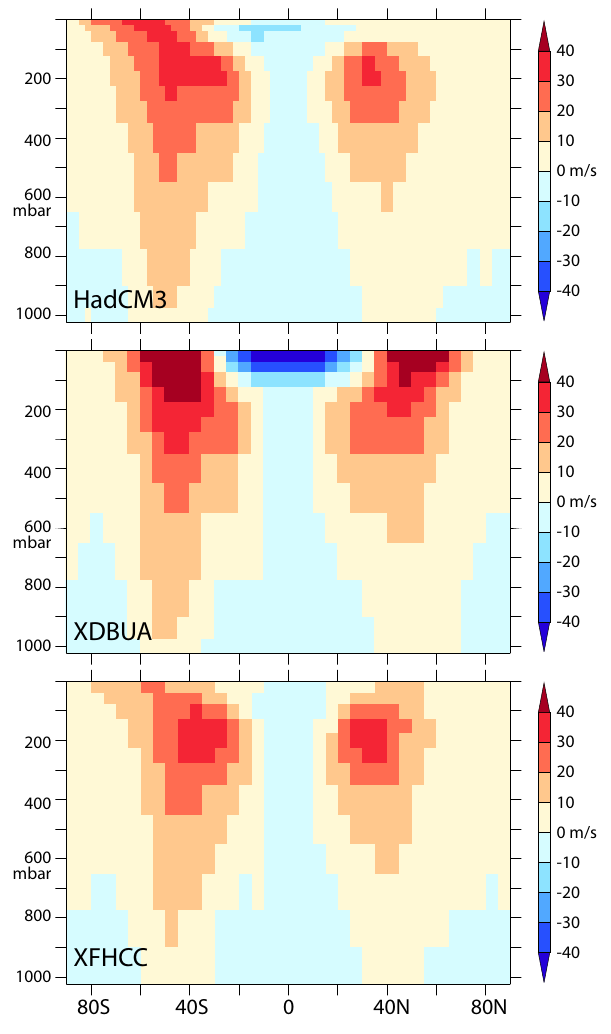
Fig. 3. Annual, zonal average zonal winds. Top: HadCM3; mid- dle: XDBUA; bottom: XFHCC.